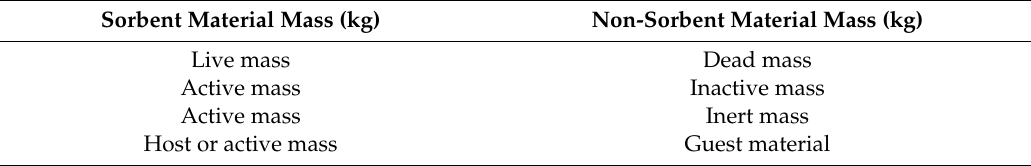
Table 1. Common terms relating to adsorption heat exchanger thermal